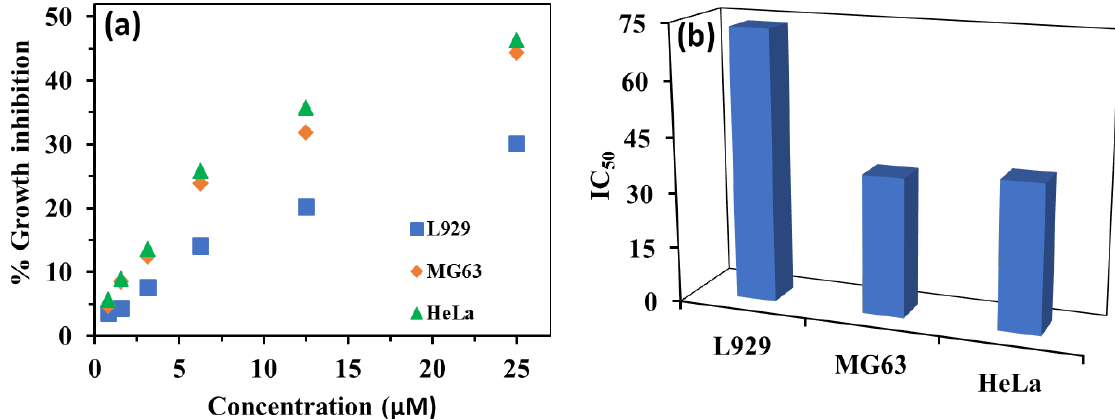
Figure 10. ( a ) Effect of increasing dose of HBT 2 (0 – 25 µM) on viability of normal and cancer cell lines and ( b ) Bar graph of IC 50 values.